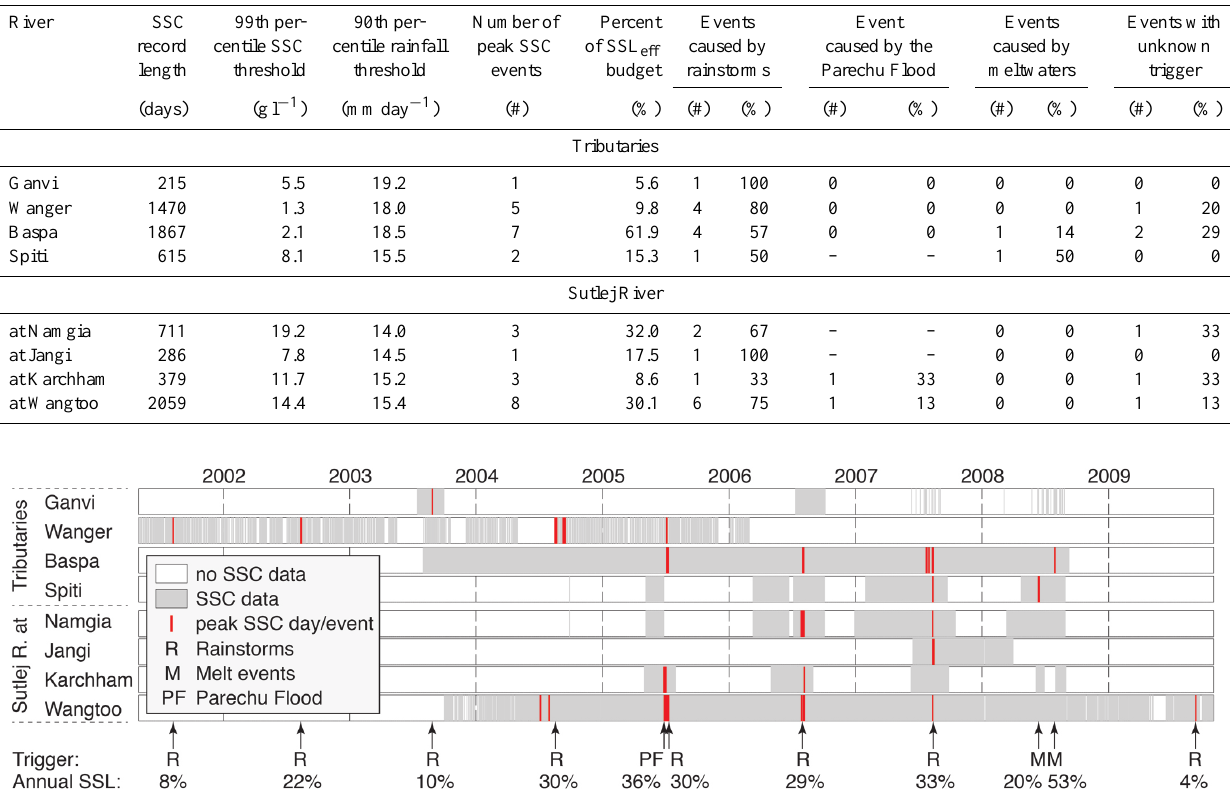
Fig. 4. Time series of peak SSC days/events within the Sutlej catchment. Plausible triggers that are related to peak SSC days/events and catchment-average percentages on the annual suspended sediment load (SSL) are indicated at the bottom. PF (Parechu Flood) is a rain-on- snow event that led to the breach of a landslide dam and caused significant flooding